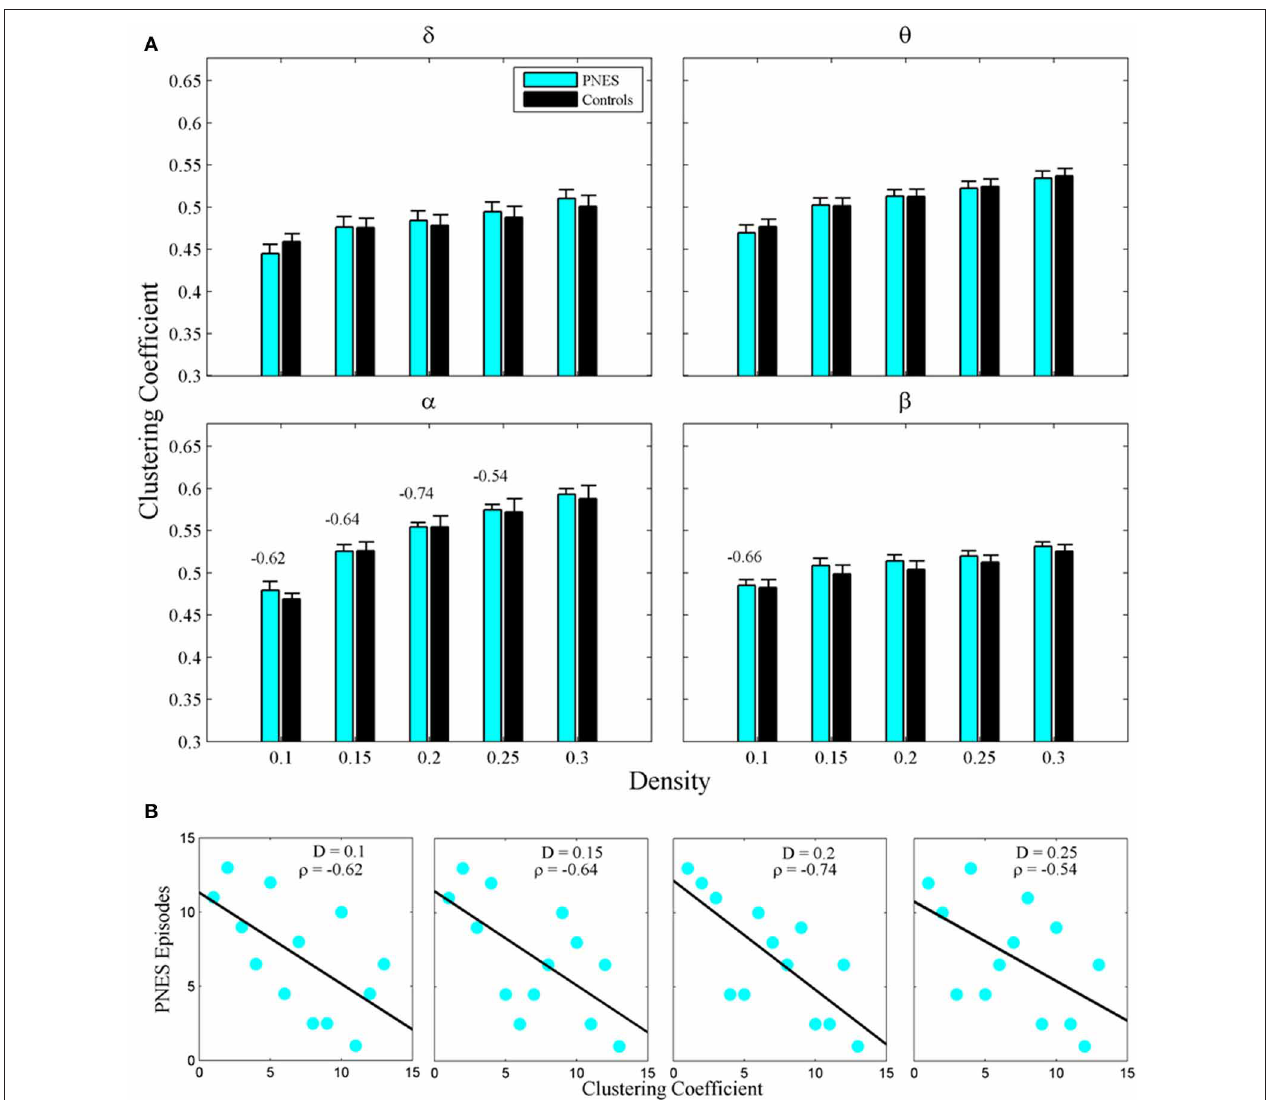
FIGURE 2 | Clustering co-efficient as a function of network density for PNES patients and controls. (A) The plots show mean values and standard errors for clustering co-efficients of functional brain networks as a function of density in the groups of PNES patients (cyan bars) and controls (black bars) for different frequency bands. For each density value d , the clustering co-efficient is averaged over the range ( d − 0 . 05, d ), e.g., the values for